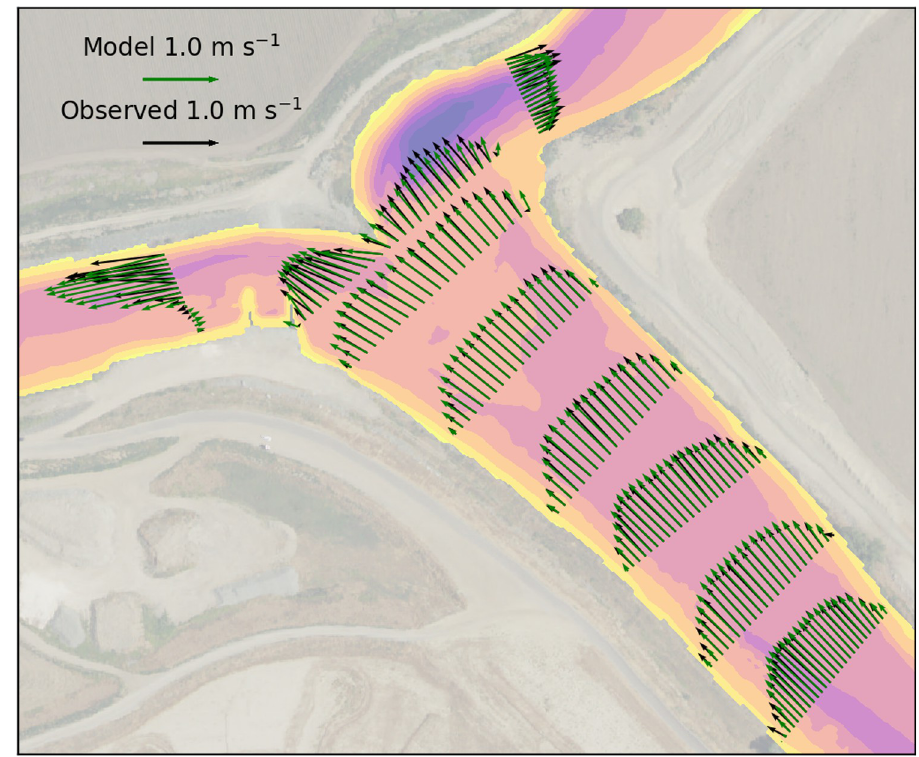
Fig 3. Location of water velocity measurements and model–data comparisons. Velocity vectors in the horizontal for each transect showing modeled (green) and observed (black) velocities averaged over the top 2 m of the water column.